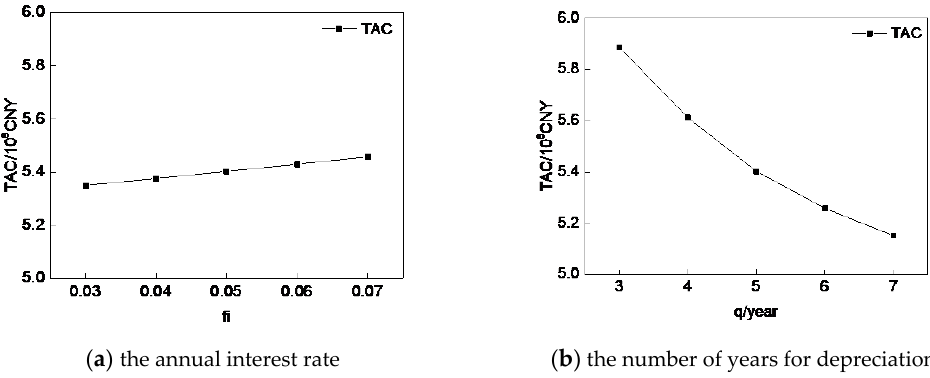
Figure 4. The influence of fi and q on the total annual cost ( TAC ).